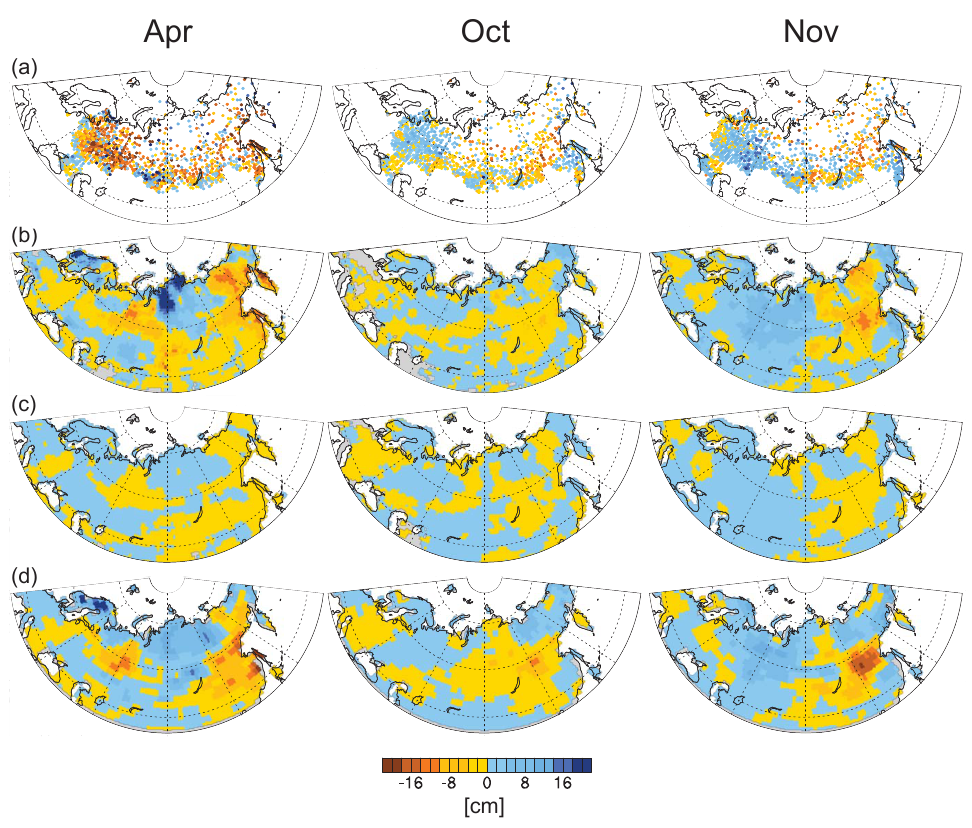
Figure 2. Snow depth anomalies of (from left to right) April, October and November for 1996–2010 minus 1981–1995 in (a) observa- tions, (b) ERA-Interim land-d, (c) ERA-20C and (d) 20CRv2c. ERA-20C land, ERA-Interim land-e and 20CRv2 are not displayed due to insubstantial differences to ERA-20C, ERA-Interim land-d and 20CRv2c.